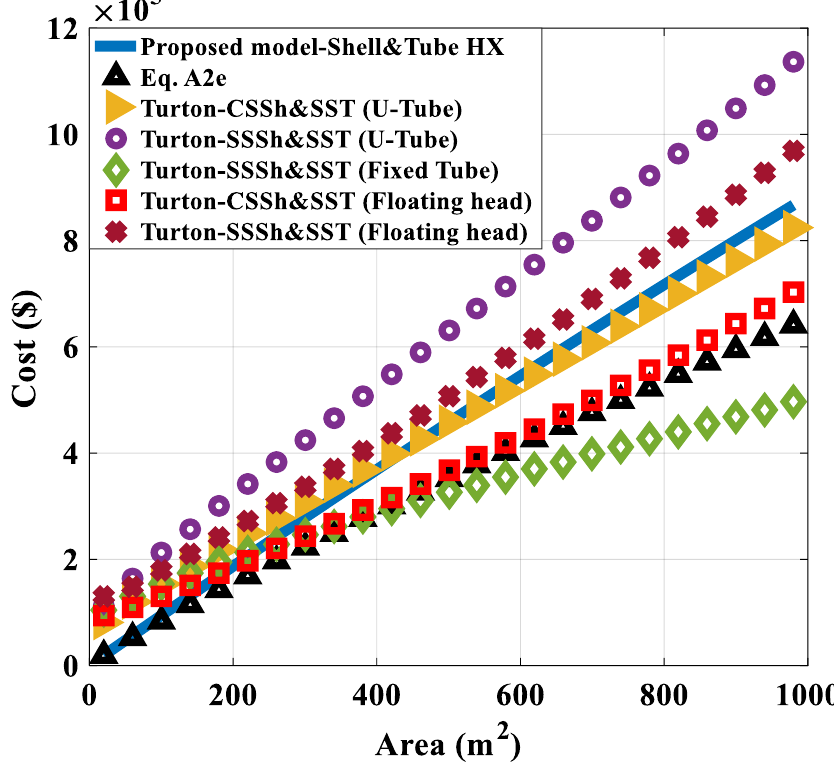
Figure 10. Shell-and-tube heat exchanger cost against the area [28,52].